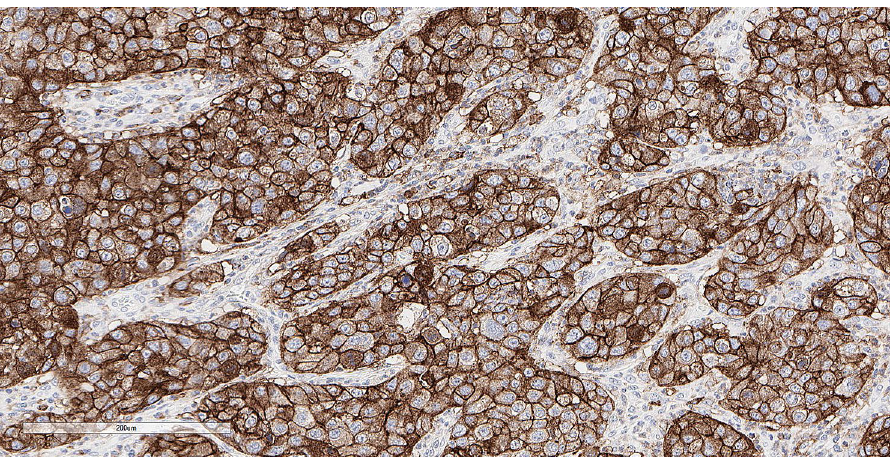
Figure 4. Another gallbladder adenocarcinoma in a 51-year old woman showing 100% high positive staining for PD-L1 in tumor cells. Note the continuous membrane staining pattern. Among other alterations, this tumor featured an STK11 loss. (peroxidase-anti-peroxidaseX200).